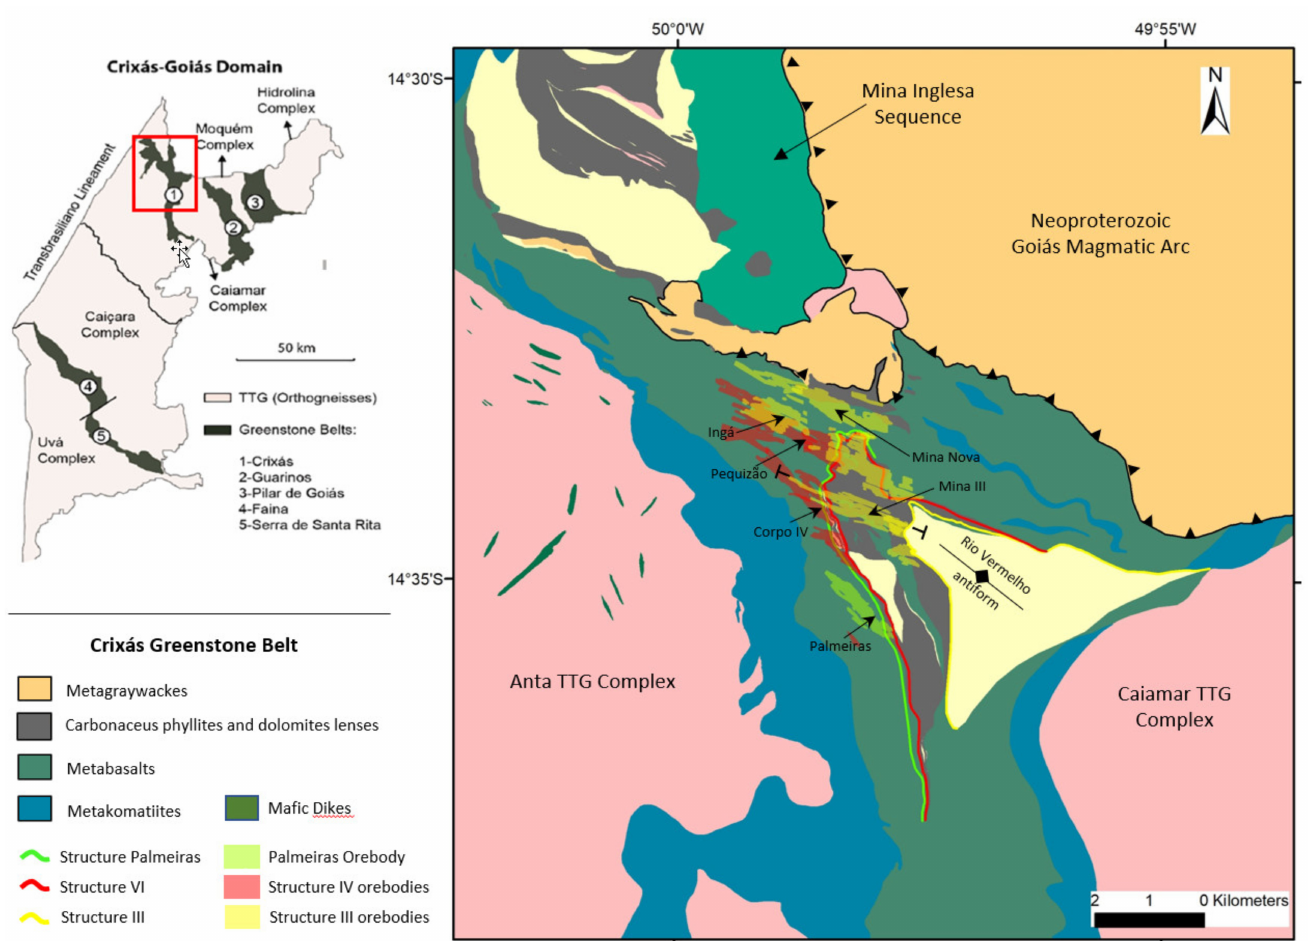
Figure 2. Geological map of the Central to Northern Domain of the Crix à s Greenstone Belt based on a long term exploration work of AGA team. Main orebodies and traces of ore horizons named as ‘Structures’ are projected on the